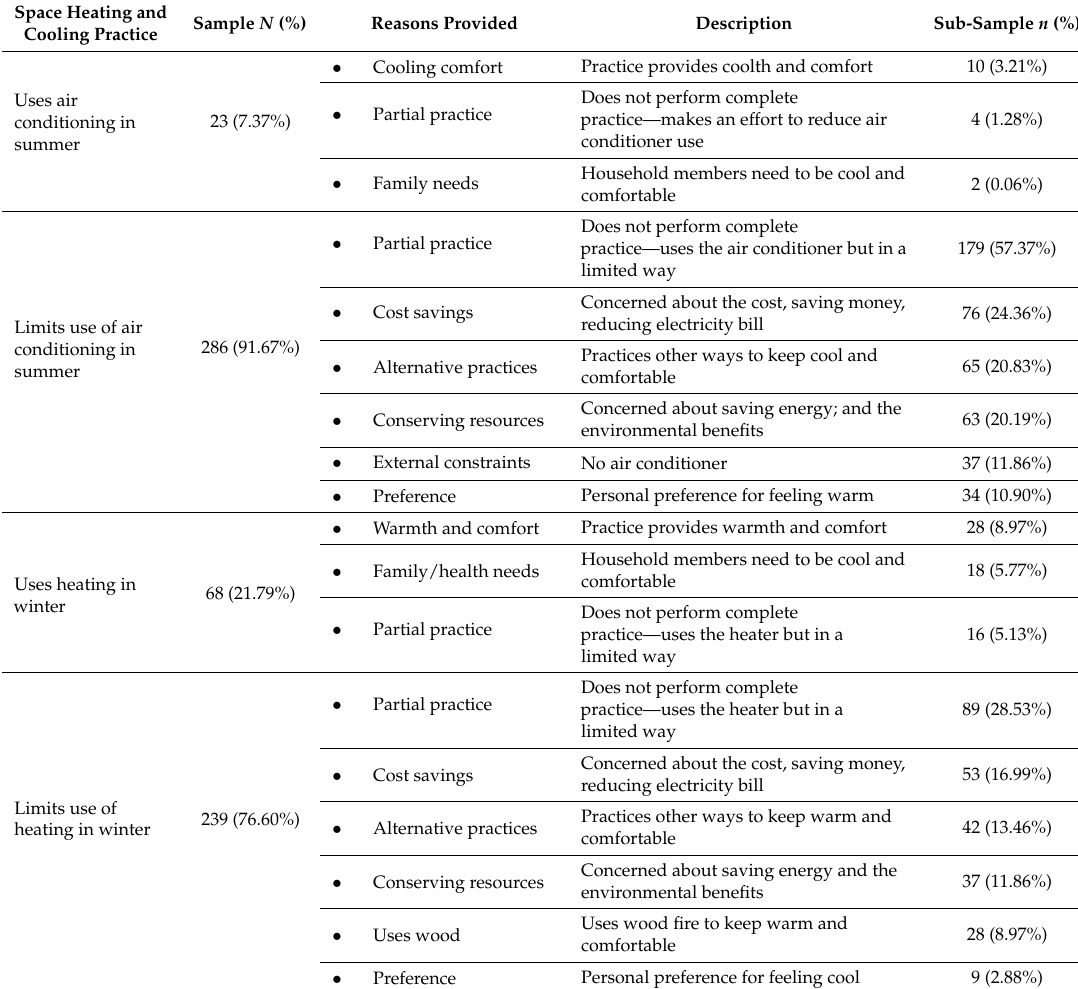
Table 4. Reasons given for engaging in energy-efficient and energy-inefficient heating and cooling practices ( N =